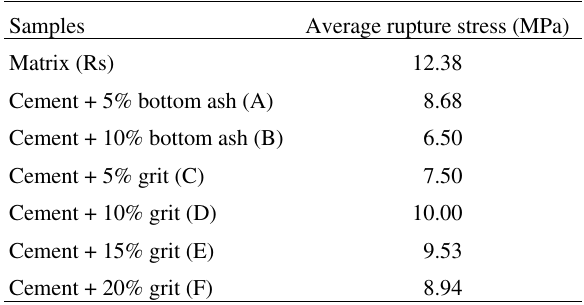
Table 4. Average strength of the samples prepared with CPI-S-32 Port- land cement after 7 days of aging. Amount of residue in volume (%).